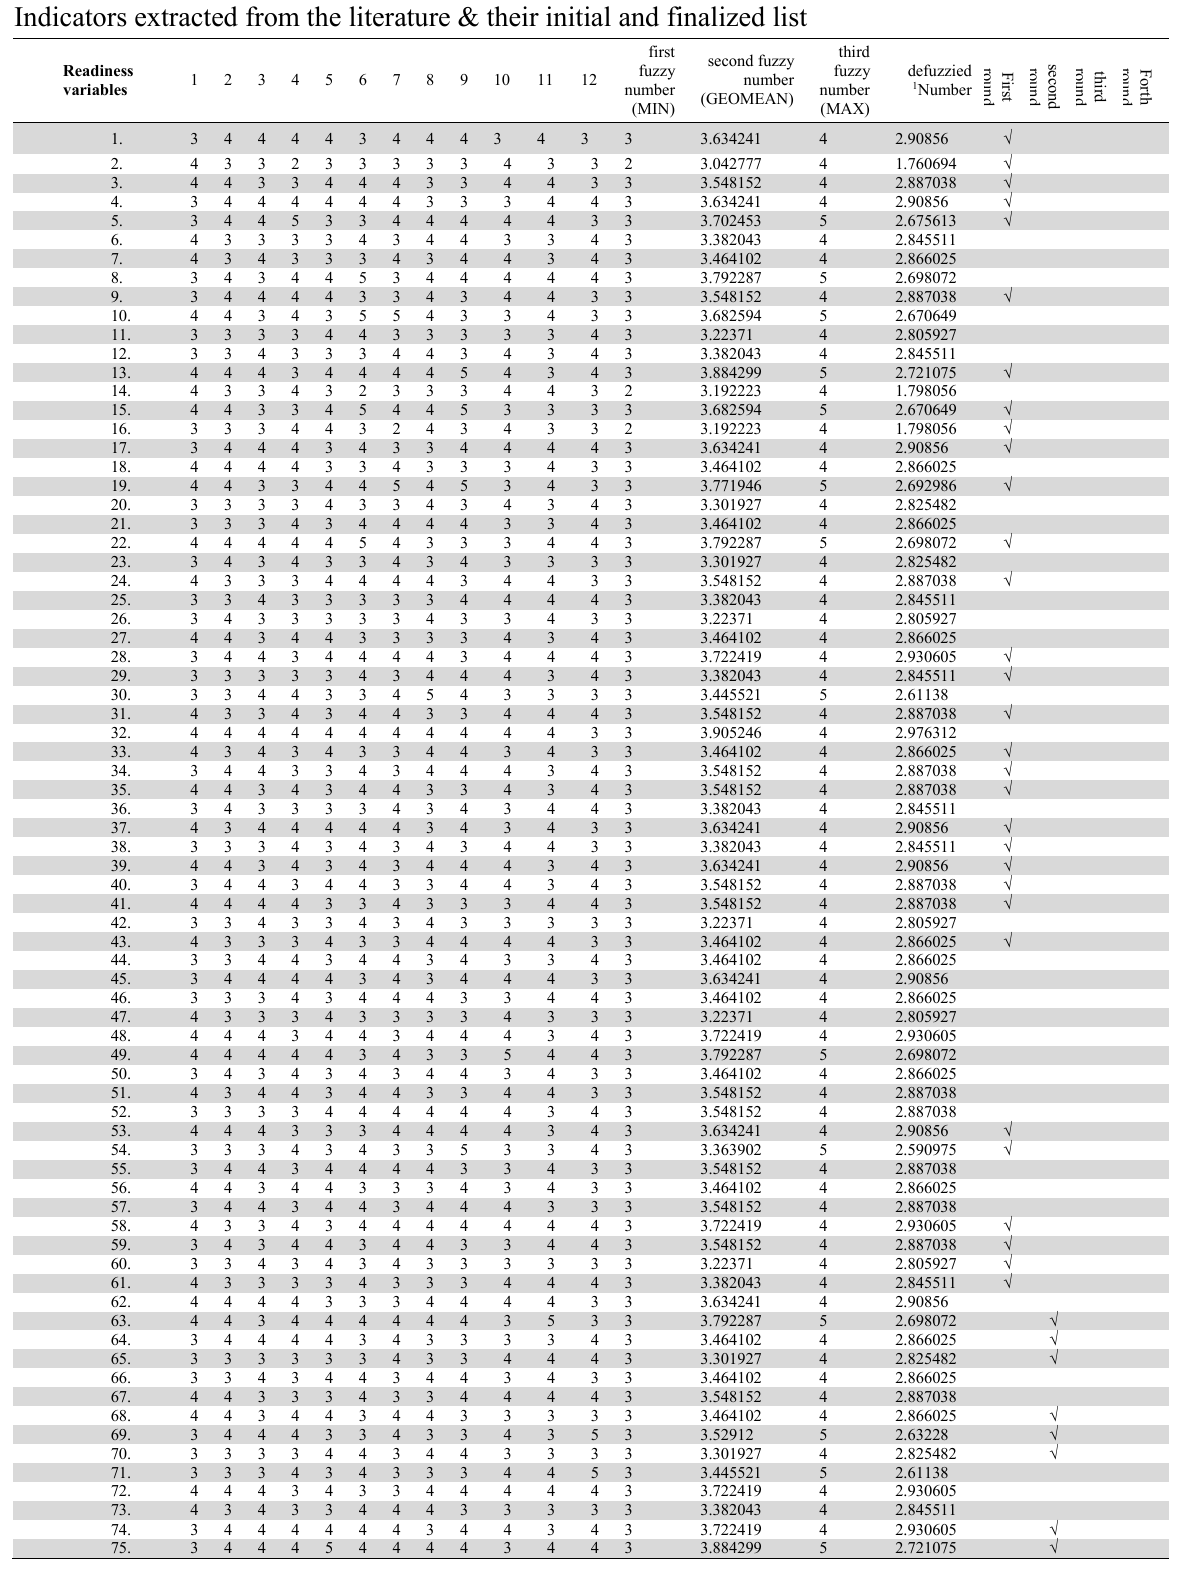
1 Min+((GEOMEAN+MAX)/4)